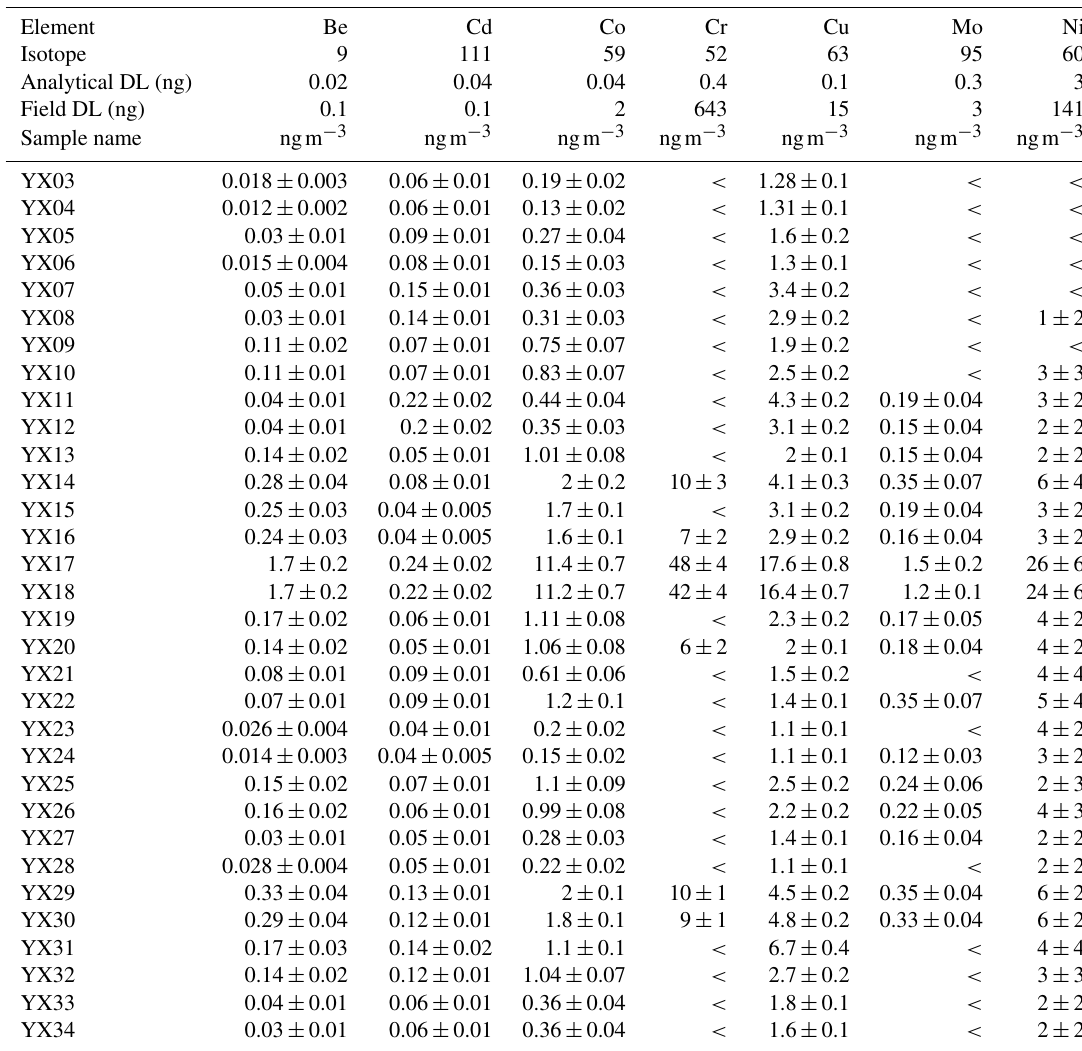
Table A4. Elemental air concentrations measured with